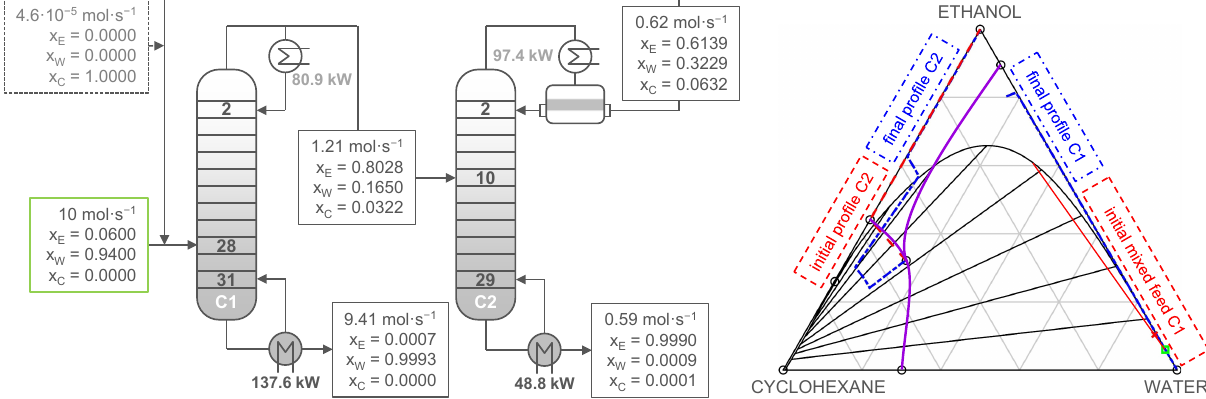
Figure 5. Optimal process design for the separation of ethanol and water using cyclohexane as a solvent in a two-column heteroazeotropic distillation setup ( left ), including the initial and final liquid composition profiles of both columns in the corresponding Gibbs diagram ( right ). The initial composition profiles of columns C1 and C2 are plotted as red cross and dashed line, respectively, while the final composition profiles of both columns are plotted as blue dot-dashed lines. The feed composition is indicated by a green square and all singular points as well as the liquid-liquid critical point are marked as black